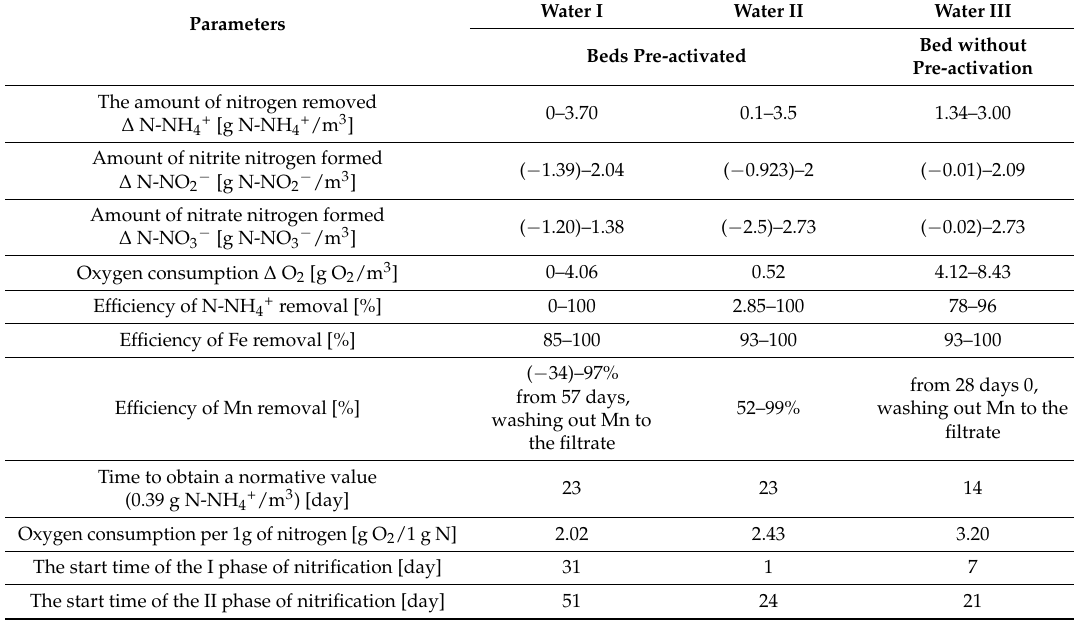
Table 7. Comparison of parameters in the biofiltration process on chalcedonite